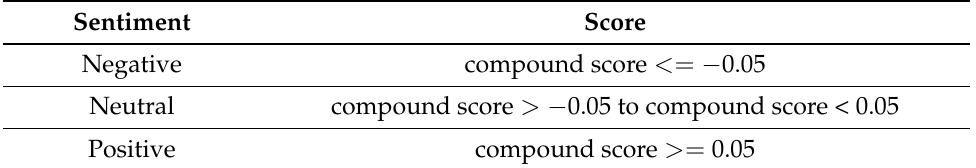
Table 7. VADER sentiment score range.